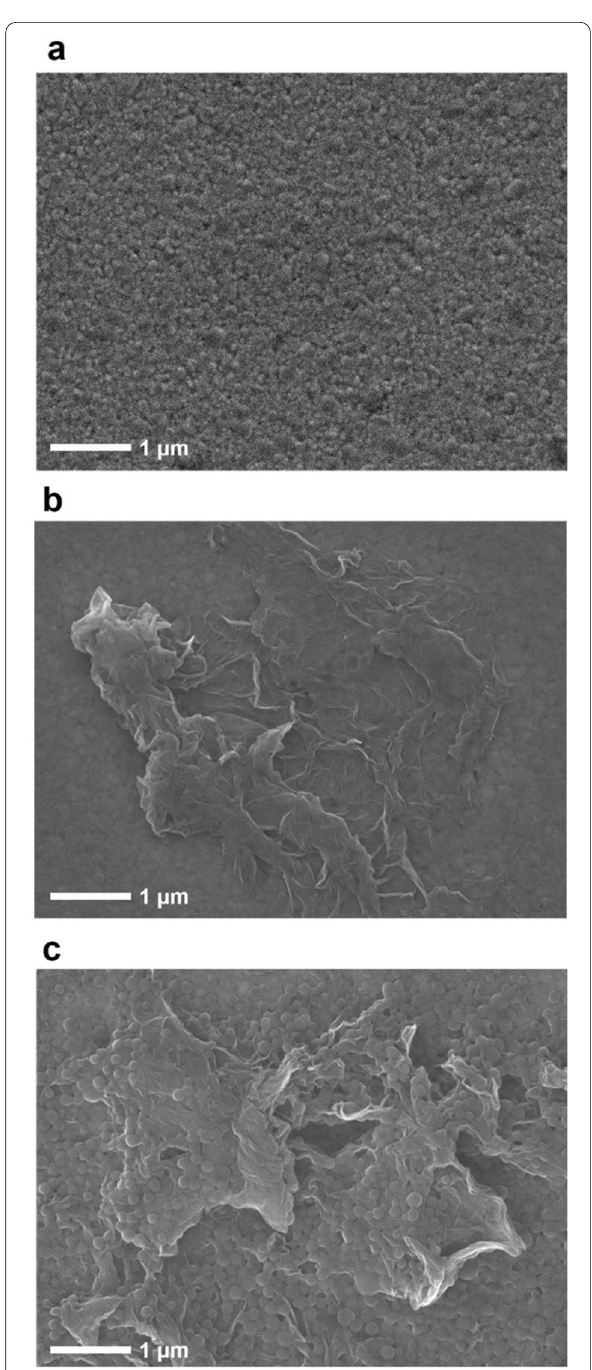
Fig. 3 FE‑SEM images of: a Bare Au electrode, b rGO/Au electrode, and c HEPNP/rGO/Au